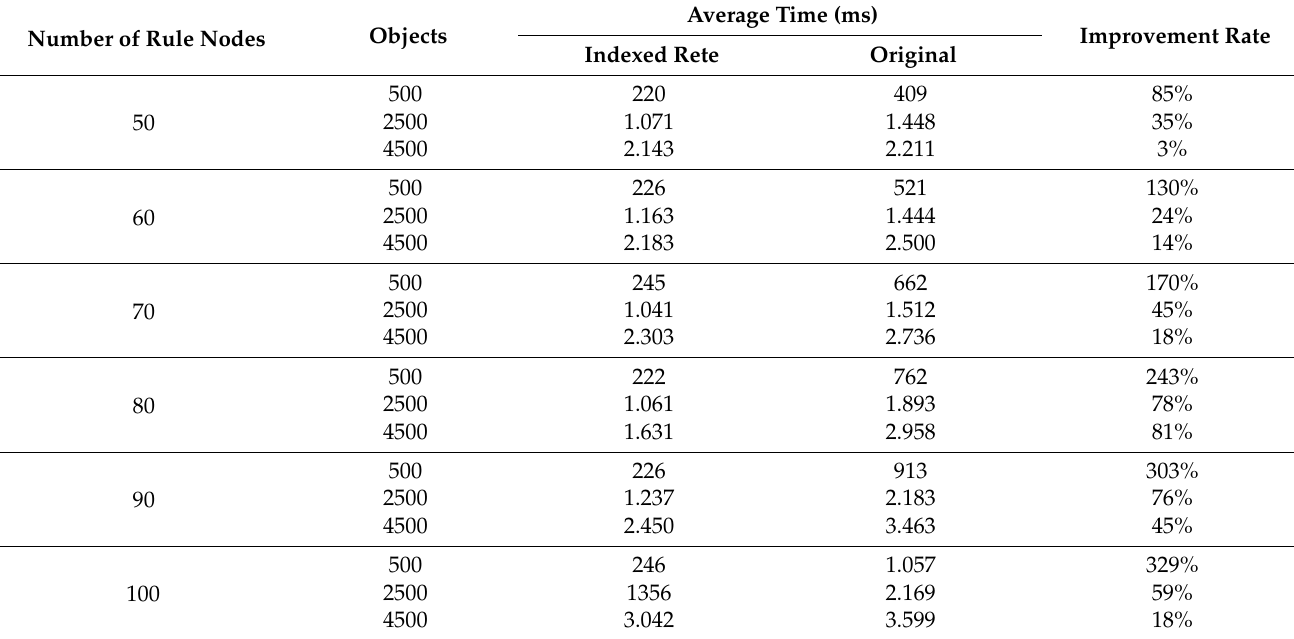
Table 4. Performance improvement ratios for uniform distribution of target objects.